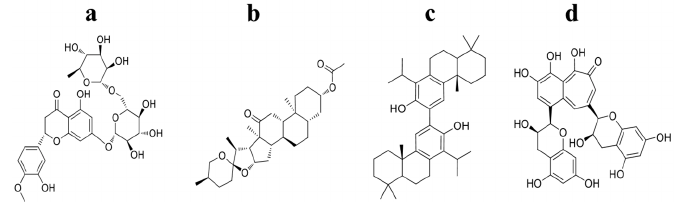
Figure 2. Four NPs selected as promissory HER Receptor inhibitors: ( a ) hesperidin; ( b ) hecogenin acetate; ( c ) podototarin; and ( d ) theaflavin.